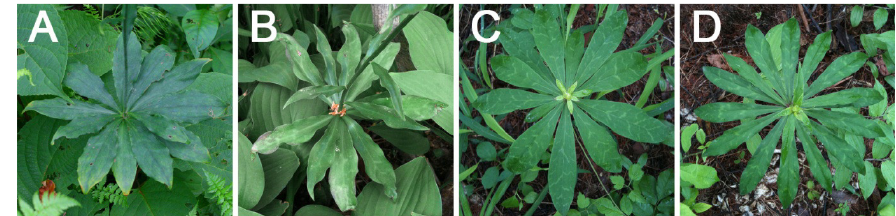
Fig. 4. Whorled-leaf variation of L. tsingtauense found in Korea; A) wide Corrugated; B) narrow corrugated; C) wide plane; D) narrow plane